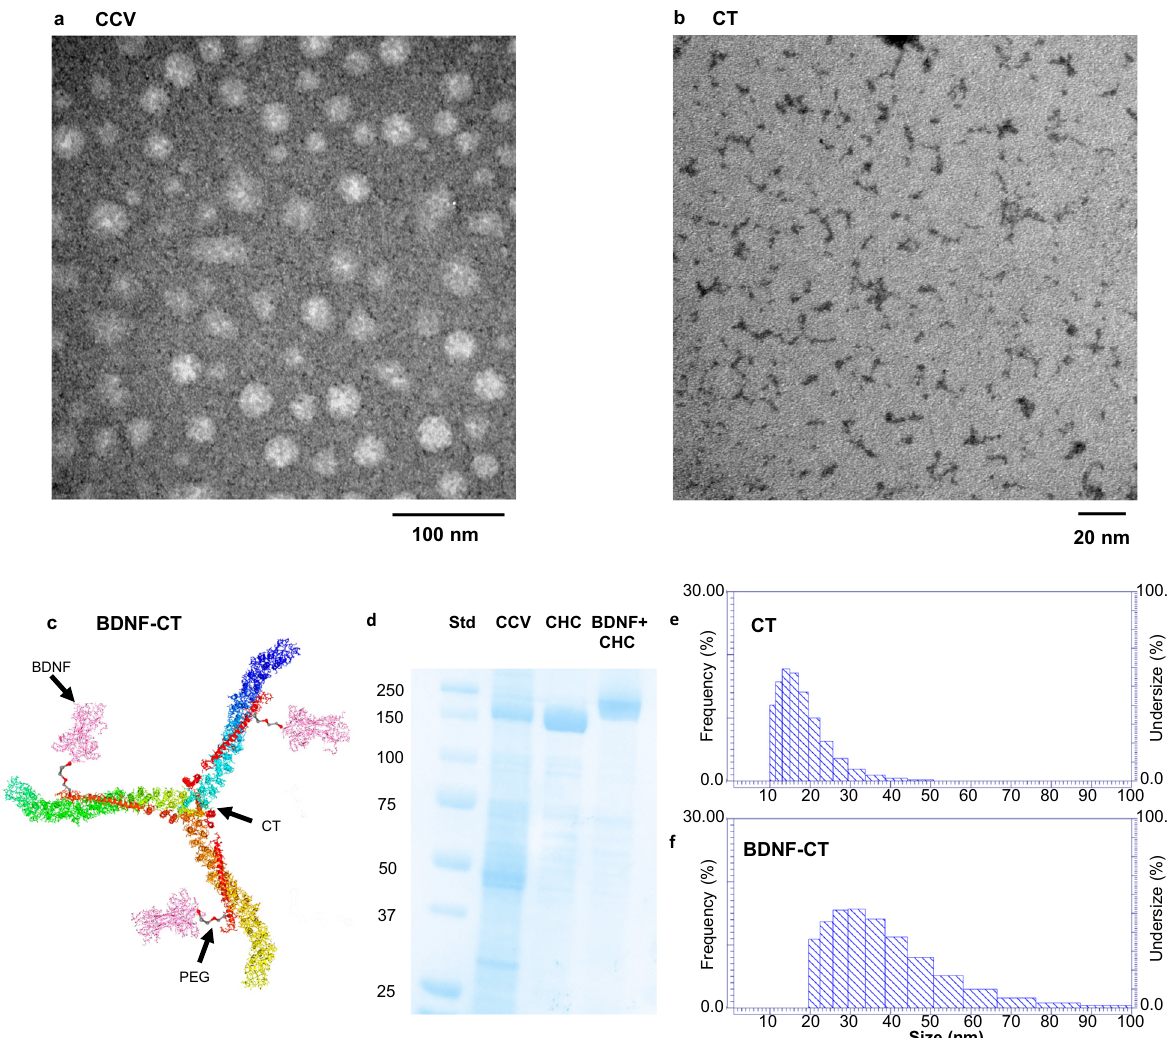
Fig. 1 BDNF-Clathrin (BDNF-CT) nanoparticle puri fi cation and characterization. Transmission electron microscopy (TEM) images show ( a ) clathrin coated vesicles (CCVs) isolated from pig brains, and ( b ) puri fi ed clathrin triskelia (CT) with attached metal (Gd) negatively stained with 1% uranyl acetate. ( c ) A graphical representation of a clathrin triskelion with three heavy chains (CHCs, yellow, blue and green) and three light chains (CLCs, red). One BDNF molecule is conjugated to the each CHC via PEG and NP solution had 2.25 mg/ml of protein (2 mg/ml of CT with 0.25 mg/ml of BDNF). ( d ) SDS-PAGE shows CCV, CT, and BDNF-CT protein bands. The CHC molecular weight increased by 30 kDa following BDNF conjugation to CT. ( e ) Dynamic light scattering (DLS) studies show the mean hydrodynamic radius ( R H ) of unconjugated CT to be 16.8 ± 5.6 nm. ( f ) The mean R H increased to 35.1 ± 12.6 nm after BDNF PEGylation and subsequent conjugation to